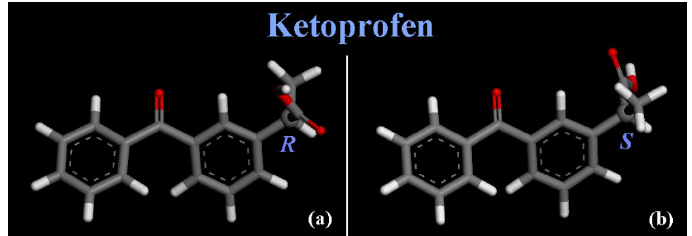
Figure 1. Optimized geometries of ketoprofen drug molecules, in particular the ( R ) enantiomer in panel ( a ) and the ( S ) enantiomer ( S ) in panel ( b ) are shown. Color code: carbon atoms are in grey, oxygens in red and hydrogen atoms in white.